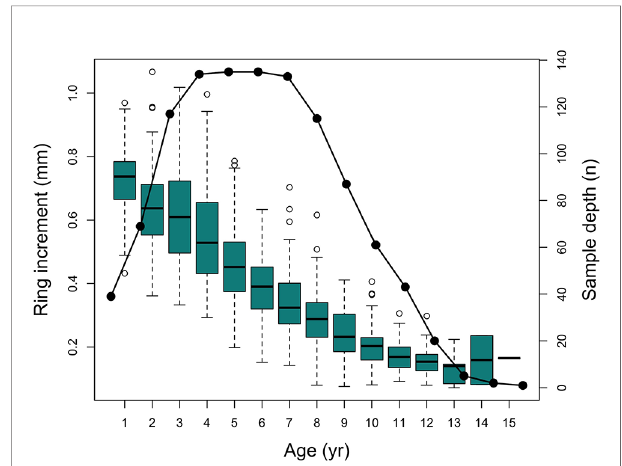
FIGURE 3 | Box-and-whiskers plot of annual increment measurements of all analyzed otoliths with lines, boxes and whiskers representing medians, interquartile range (IQR), and 1.5 IQR respectively. White circles represent outliers; black circles represents sample